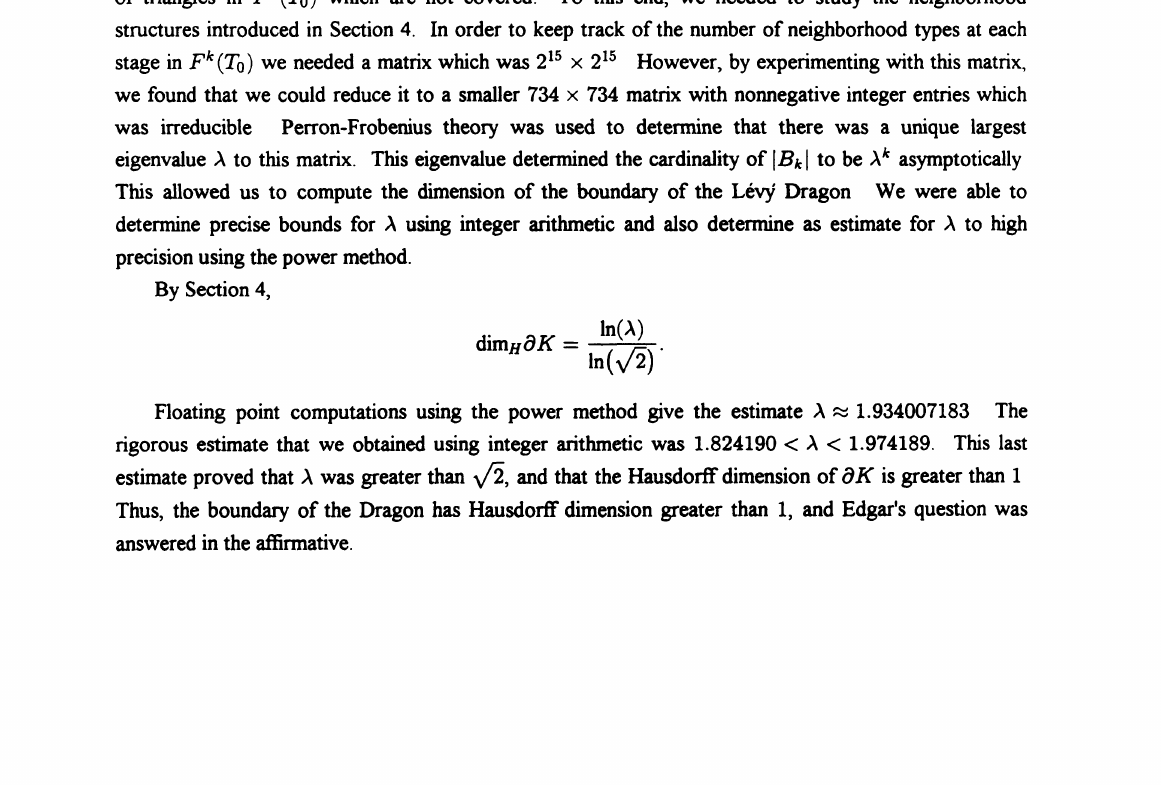
Figure 4. Ns and